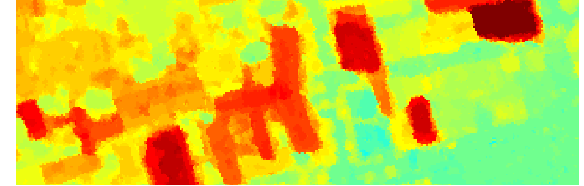
Figure 12. Results with the OrthoAdjust pipeline.